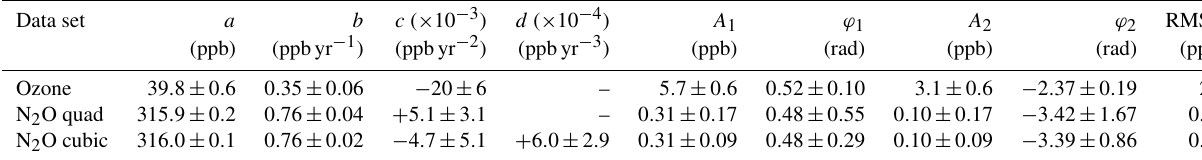
Table 2. Parameter values of fits of long-term change and seasonal cycle in Mace Head, Ireland, data to Eq. (4). Data set